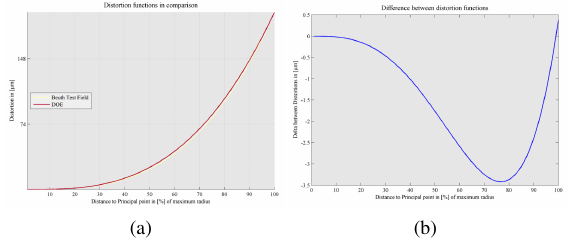
Figure 5. (a) Distortion functions from k 1 and k 2 for both approaches (b) DOE distortion function subtracted from test field distortion function